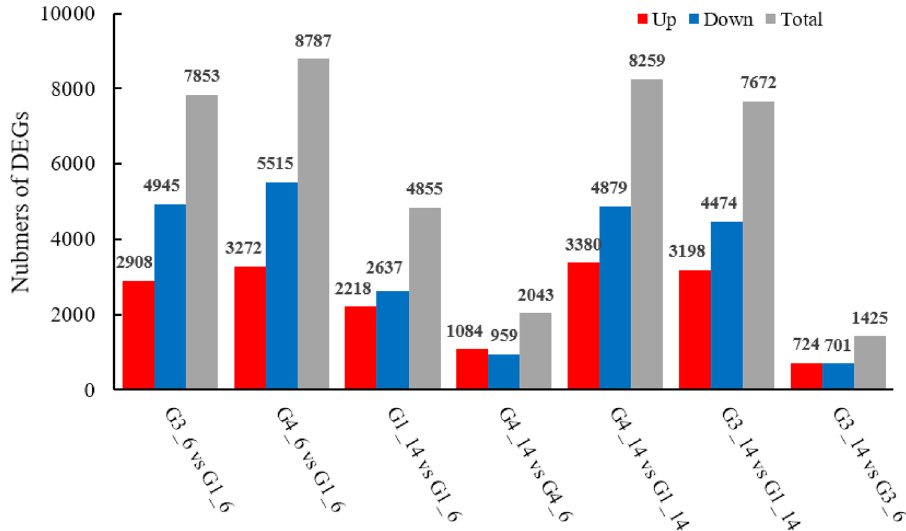
Figure 3. Differentially expressed genes (DEGs) between different samples of the two melon